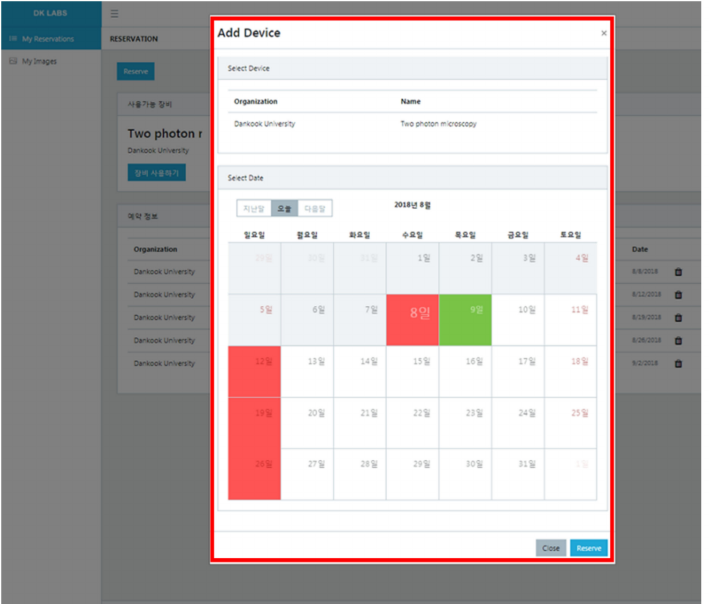
Figure A4. The user interface of the equipment selection page. The red box is a calendar for